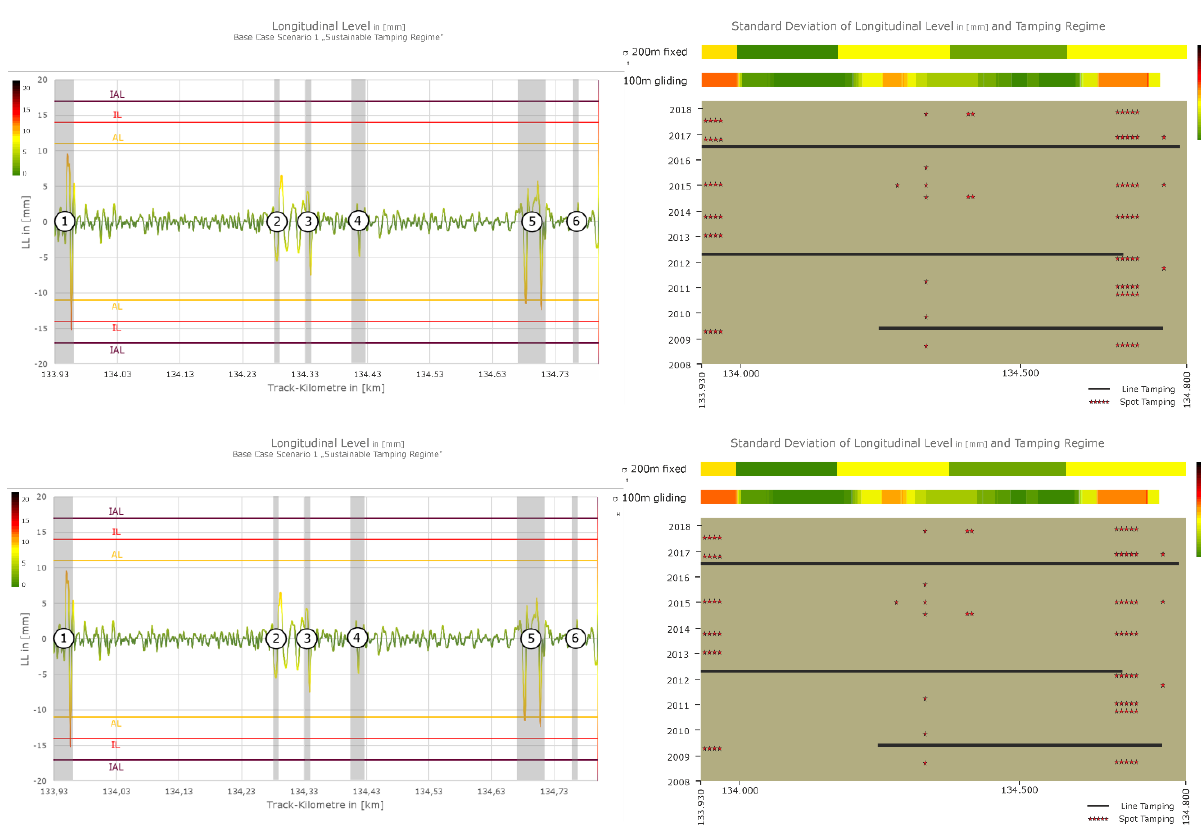
Figure 4. Showing the Longitudinal Level at the last Measuring in Q12018 ( left ) including the Single Failures (1 to 6), SDLL for 100 m gliding and 200 m fixed Base at Q12018 and the executed Line-Tamping and Spot Tamping Tasks over Time ( right ) for the Base Case Scenario (Scenario 1).